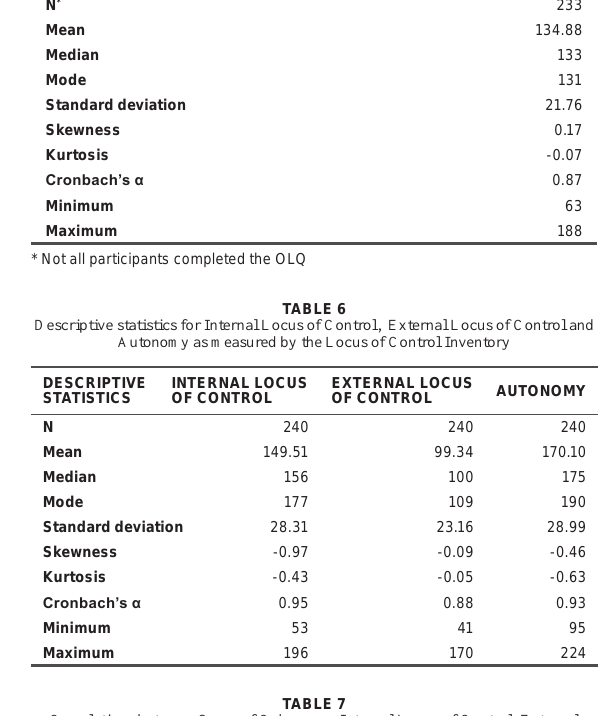
TABLE 7 Correlations between Sense of Coherence, Internal Locus of Control, External Locus of Control, Autonomy and Stress